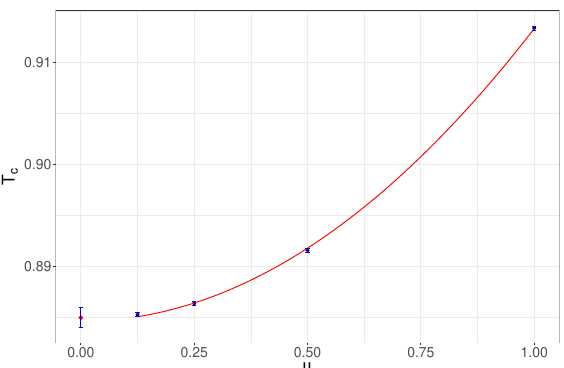
Figure 12. Transition temperatures for the bosonic BMN model against fluxes µ . The paren- thesis indicates the errors of the fit, and the left-most point is the extrapolated BFSS transition temperature (matrix size N = 64 , lattice size L = 24 ) from [64]. The fit is given by the equation T c = 0 . 8846(01) + 0 . 0297(02) µ 2